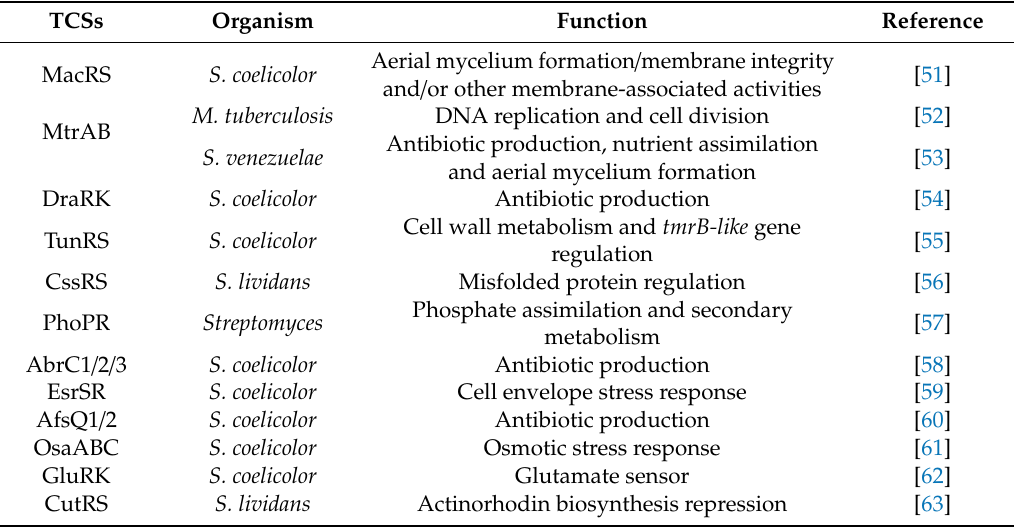
Table 2. The conserved two-component systems (TCSs) in